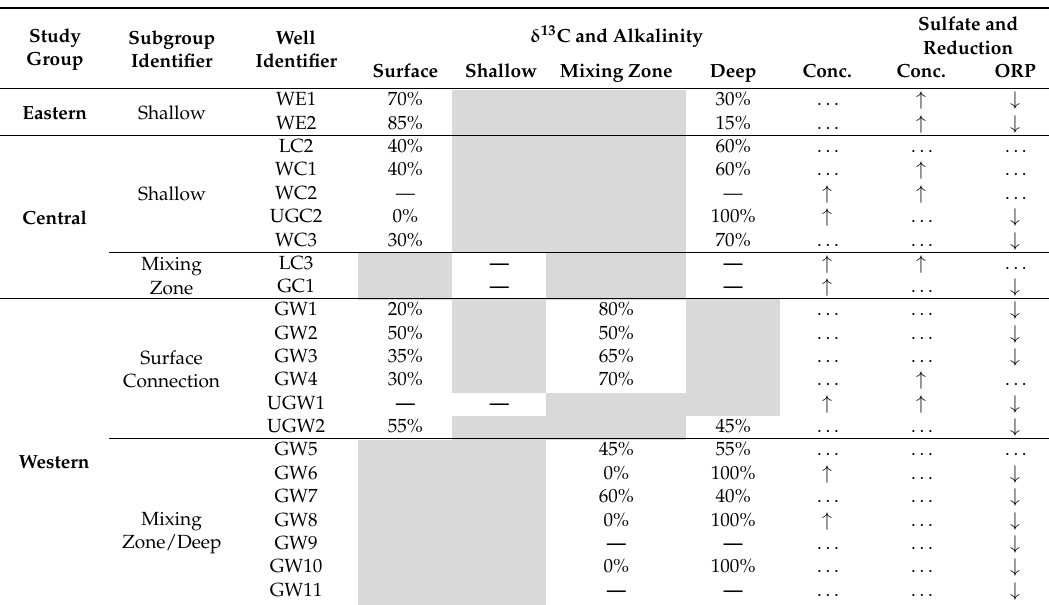
Table 6. Inverse modeling results for δ 13 C and alkalinity concentrations and evaluation of sulfate concentrations and ORP values for groundwater collected from wells in the South Fork Palouse River Basin. The same potential source waters (Surface, Shallow, Mixing Zone, Deep) used for the water isotope modeling were selected for the carbon modeling. Source waters not included in the inverse model are shaded in gray. Modeling attempts that could not produce an acceptable fit were denoted with an “—”. “ . . . ” represents no change in relative concentration (Conc.) or ORP compared to shallow recharge without agricultural